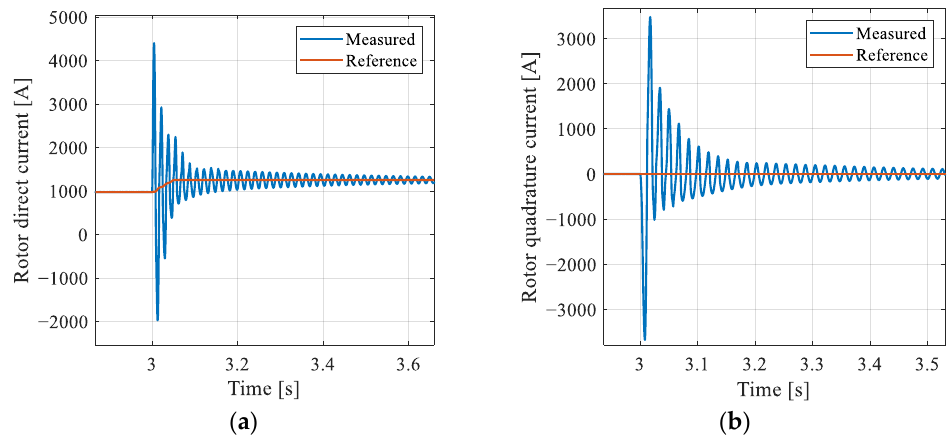
Figure 10. RSC currents during a balanced voltage sag: ( a ) d axis component and ( b ) q axis component.